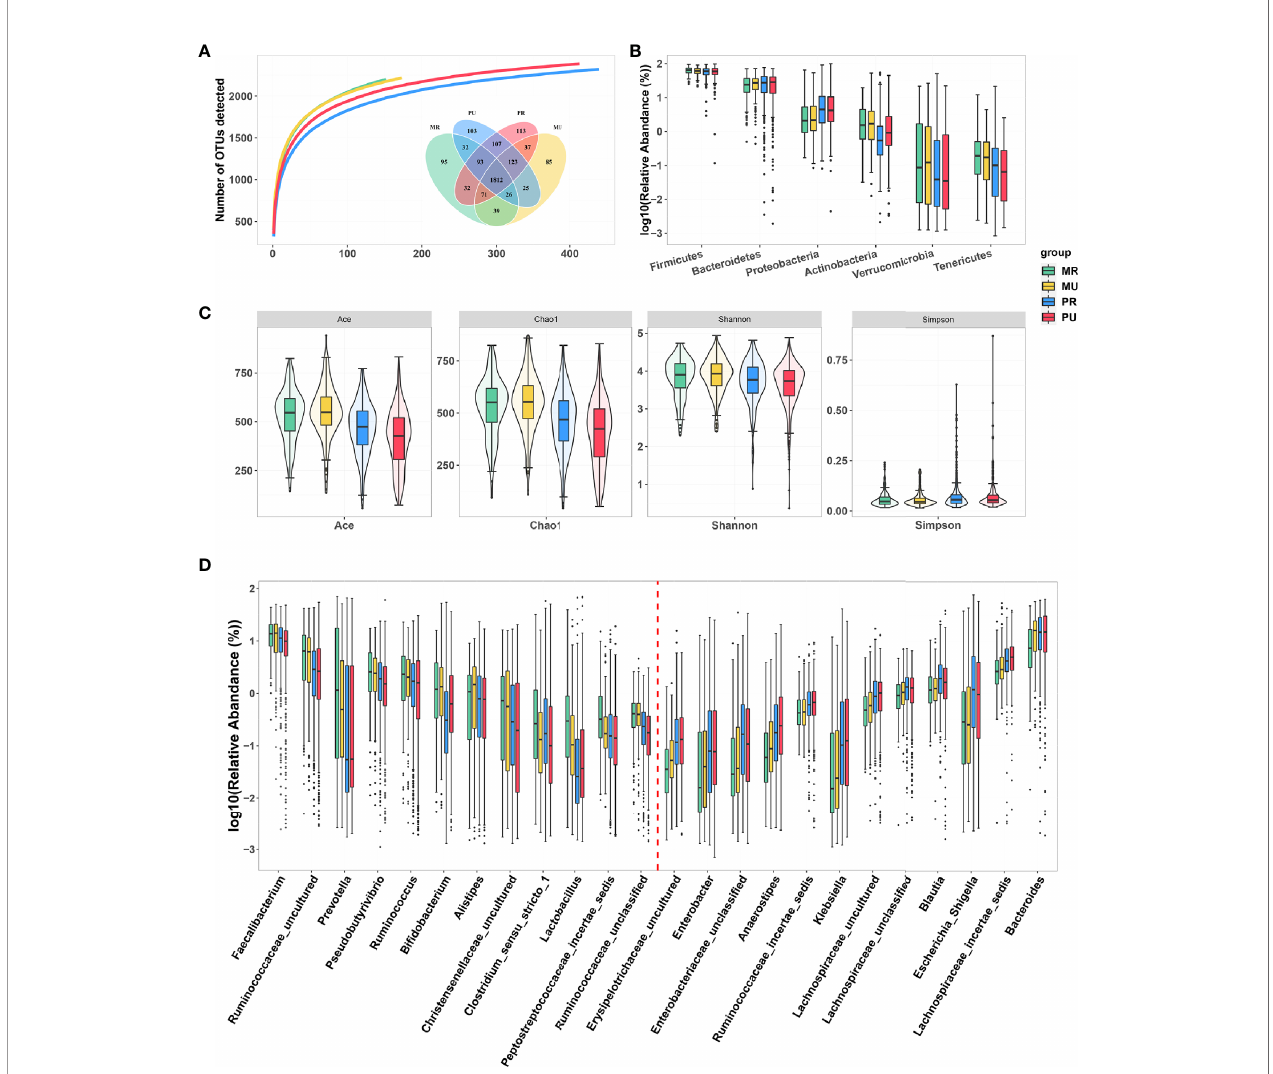
FIGURE 4 | Gut microbial diversity of participants in the MR, MU, PR, and PU groups. (A) The rarefaction analysis between the number of samples and the number of OTUs. As the number of samples increased, the number of OTUs approached saturation in MR (n = 152), MU (n = 173), PR (413) and PU (439) groups. A Venn diagram displaying the overlaps between groups showed that 1892 of the total number of 2793 OTUs were shared in the four groups. (B) Taxonomic composition of the gut bacteria on the phylum level of the MR, MU, PR, and PU groups. The gut microbiota of the four groups are dominated by Firmicutes , followed by Bacteroidetes , Actinobacteria and Proteobacteria . (C) Diversity estimation of the 16S ribosomal RNA gene library of the MR, MU, PR, and PU groups. MR, Mountain rural; MU, Mountain urban; PR, Plain rural; PU, Plain urban; OTUs, operational taxonomic units; PCoA, principal coordinate analysis. (D) The signi fi cantly different bacterial genera based on Wilcoxon rank-sum test in the four groups. With the deepening of urbanization, the abundance of some bacterial genera decreased (left box) and some increased (right box) as shown by red line delimited.